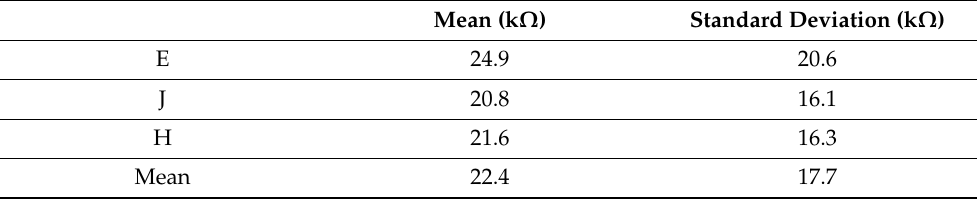
Figure 8. Mean impedance magnitude ( a ) and phase angle ( b ) with standard deviation of electrodes at in-ear locations E, J and H. n = 8. Table 3. Magnitude of mean and standard deviation of impedance of the in-ear electrodes at 10